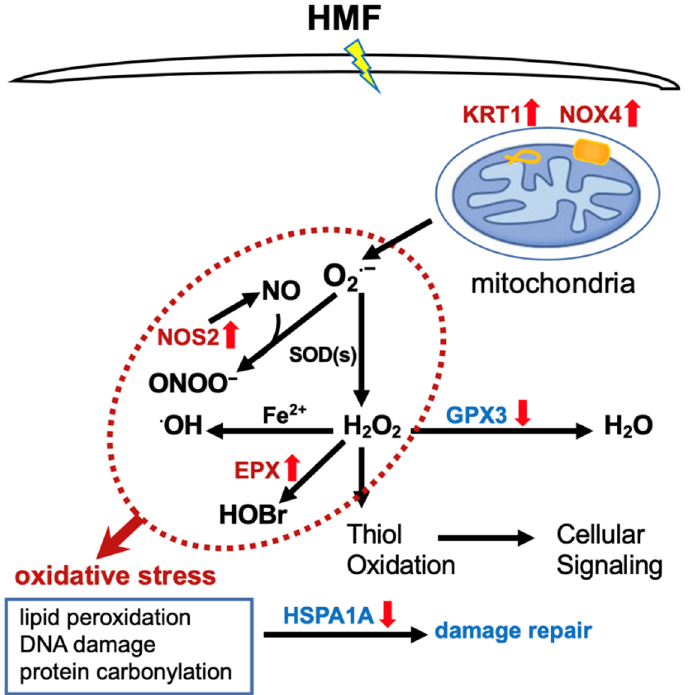
Figure 3. Schematic diagram of how the hypomagnetic field increased ROS production to induce oxidative stress by regulating several key gene expressions.